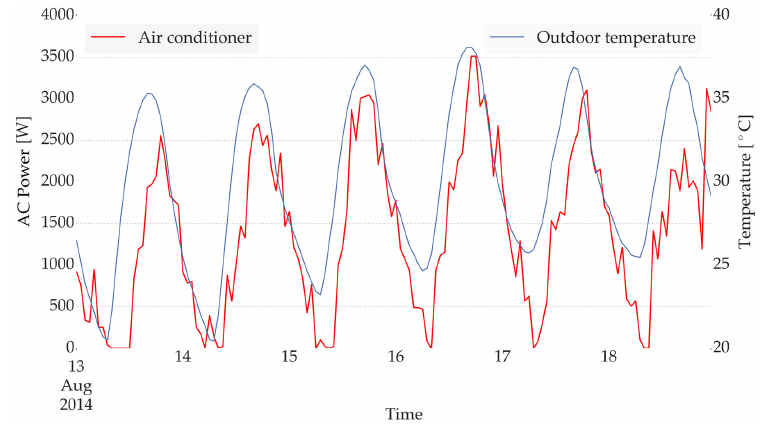
Figure 4. Correlation of temperature and AC power.